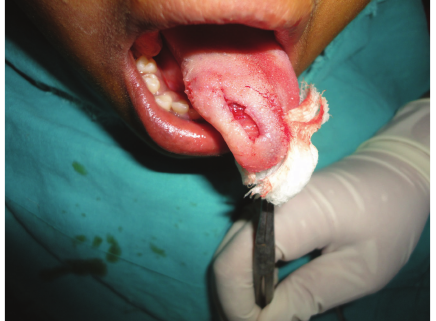
Figure 3: Complete excision.